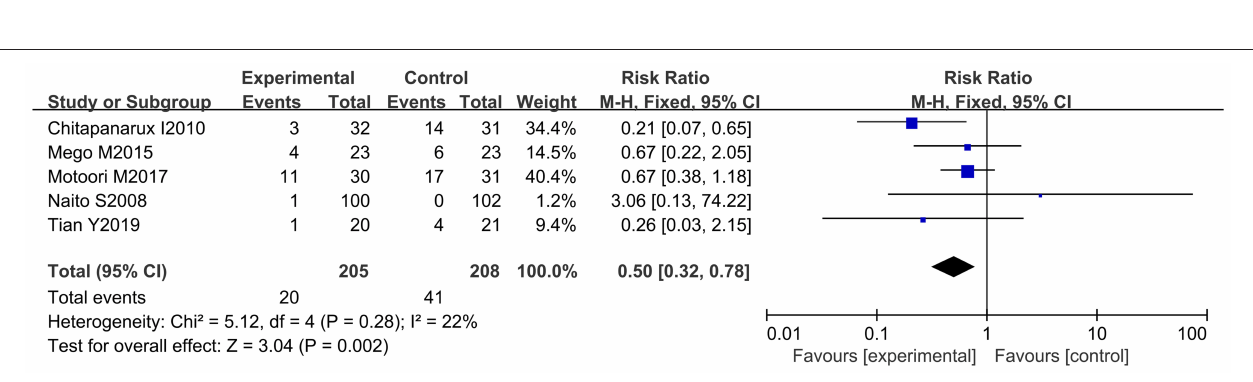
FIGURE 5 | Forest plot of orally administrated probiotics for reducing severe diarrhea in cancer patients.